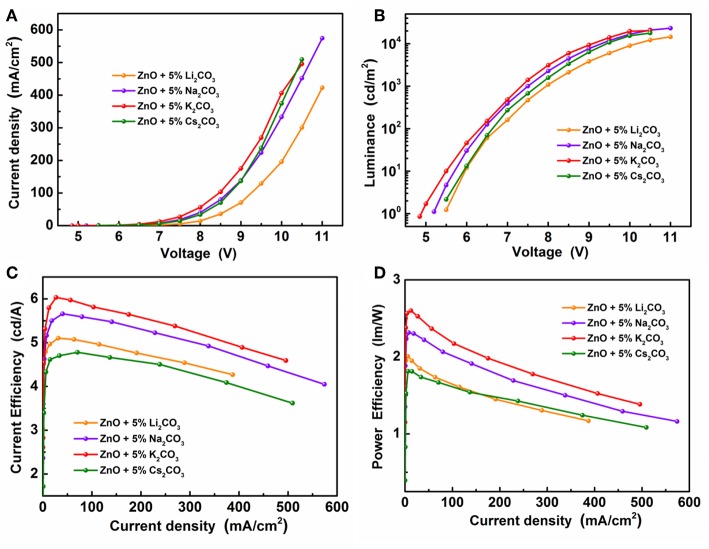
(A) The J-V characteristics, (B) the L-V characteristics, (C) the current efficiency and (D) the power efficiency characteristics of the IOLEDs based on the doped ZnO:Li2CO3, ZnO:Na2CO3, ZnO:K2CO3, and ZnO:Cs2CO3 EILs.